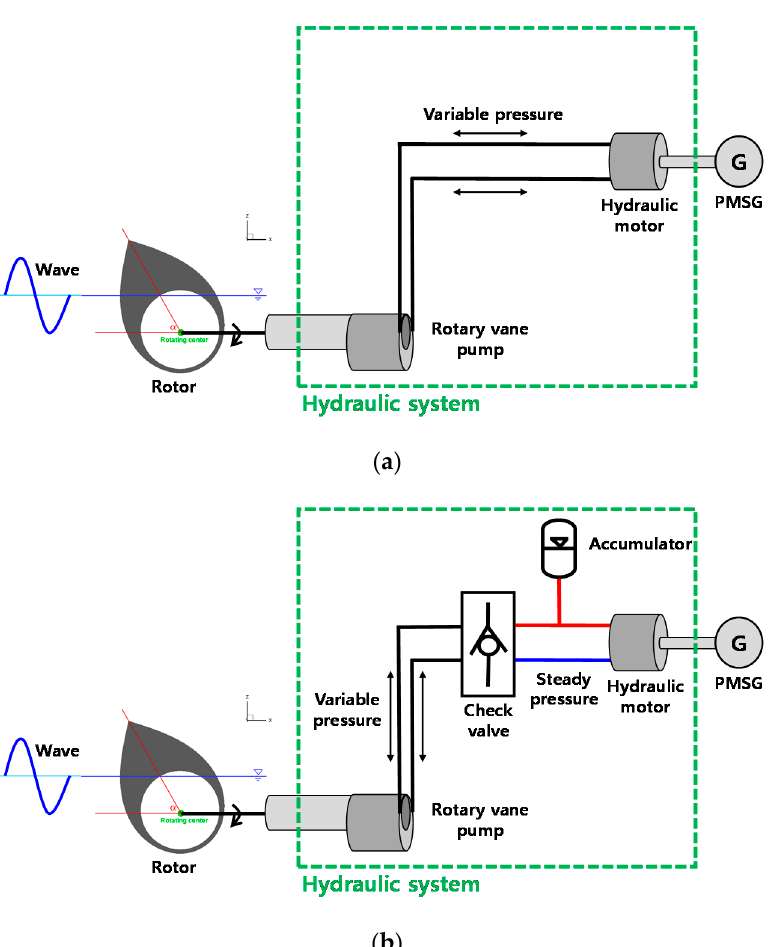
Figure 1. Basic hydraulic transmission system model: ( a ) direct hydraulic motor system and ( b ) rectifying valve accumulator motor.